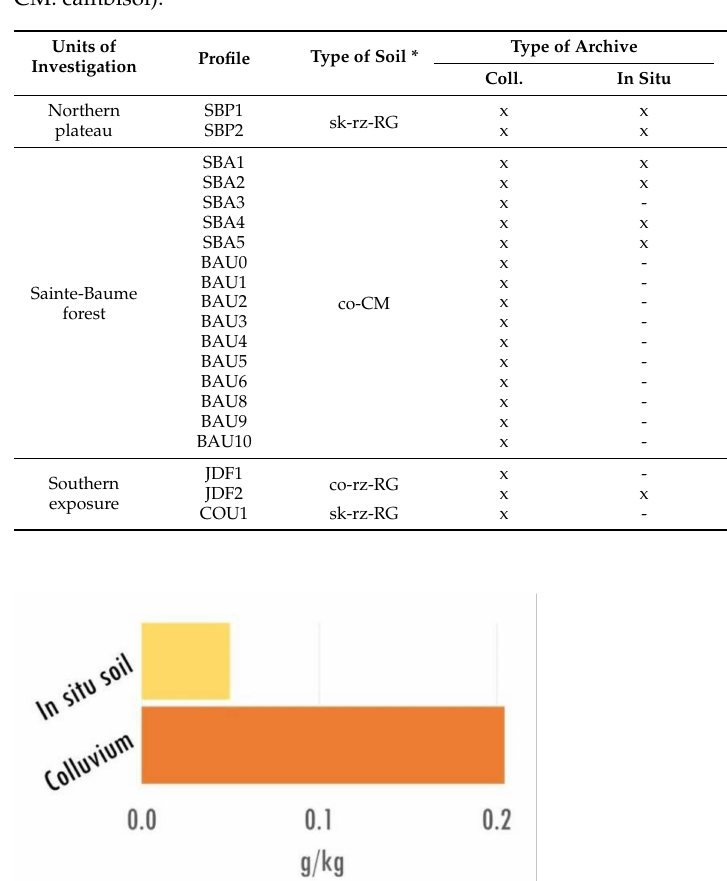
Table 1. Overview of the material from sampled soil profiles (* soil classification and soil qualifiers according IUSS Working Group WRB 2015: sk: skeletic, rz: rendzic, co: colluvic, RG: regosols, CM: cambisol).